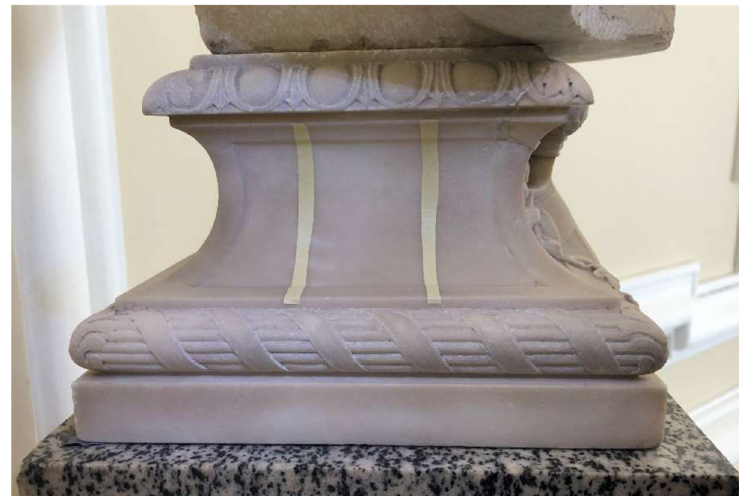
Figure 2. Cleaning areas selection and delimitation.